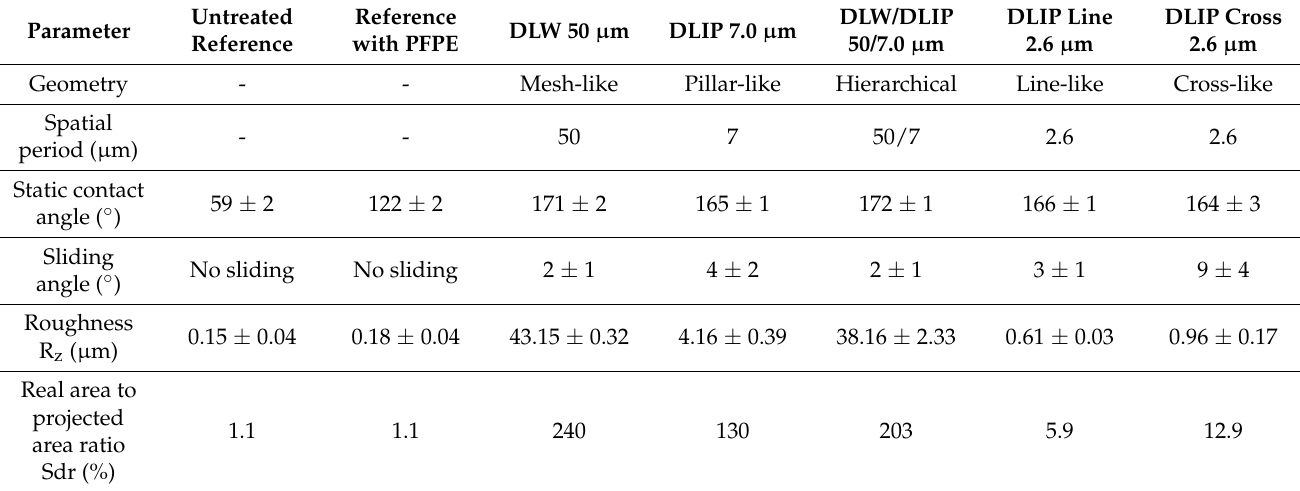
Table 1. Topographical and wetting characteristics of the fabricated samples treated with perfluoropolyether (PFPE), direct laser writing (DLW), direct laser interference patterning (DLIP) and an combination of DLW and DLIP (DLW/DLIP). Parameter